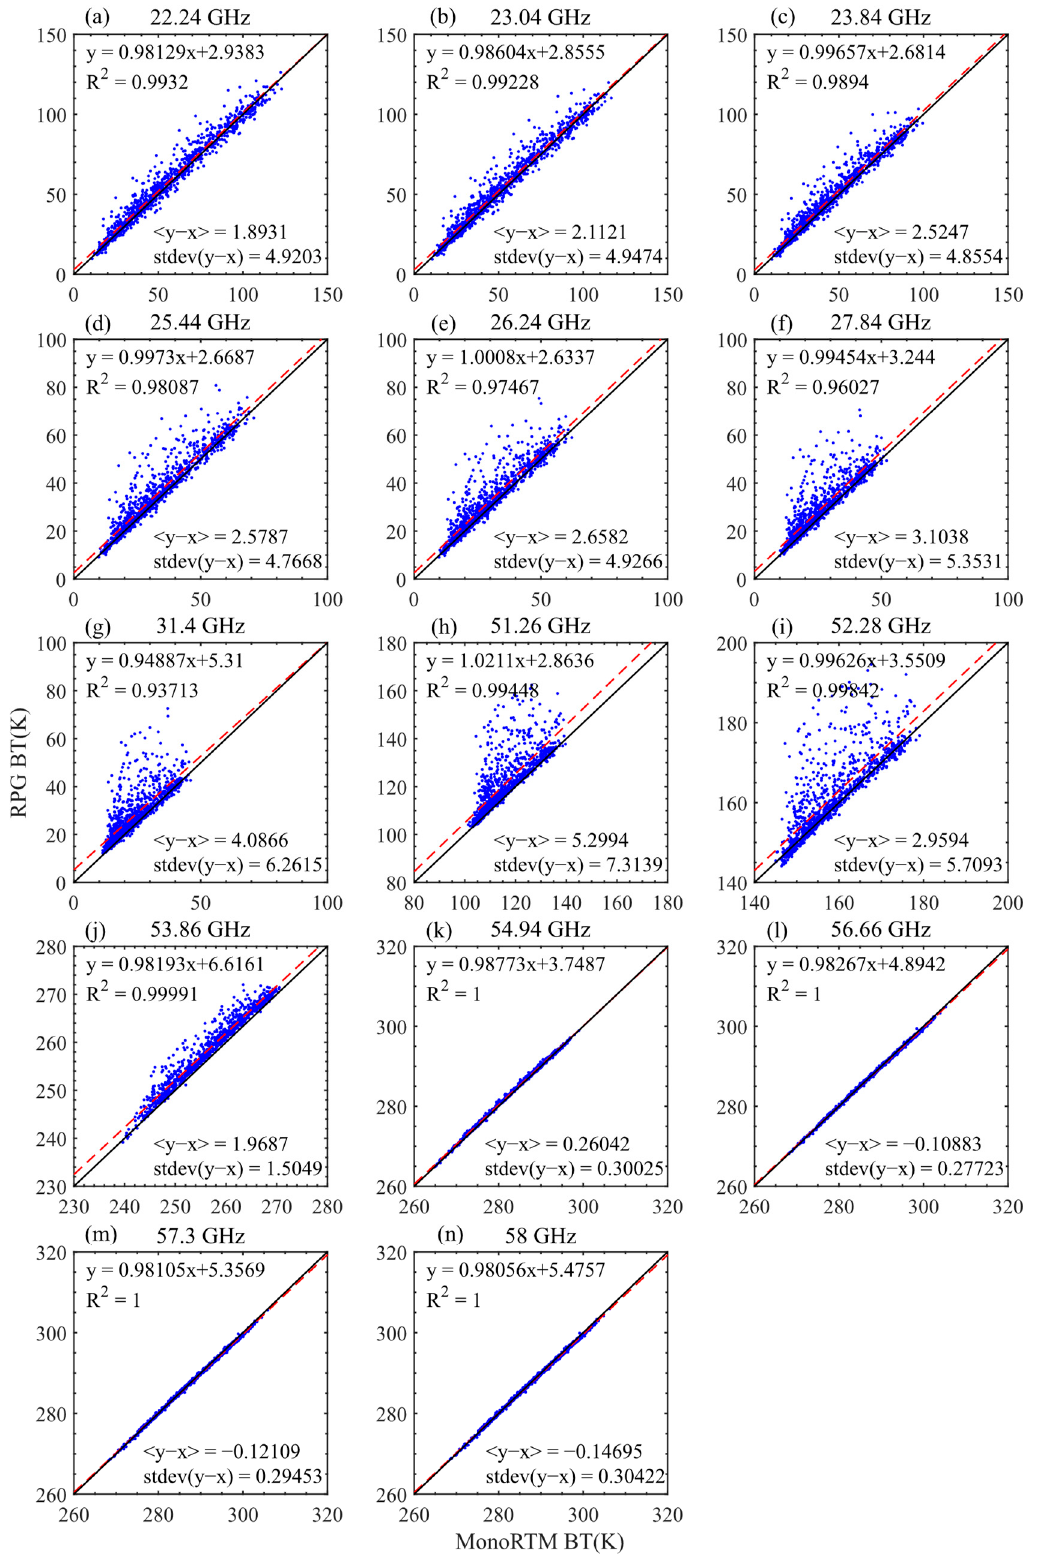
Figure 5. Scatter diagrams of observed BTs and simulated BTs in the no-precipitating cloudy weather (the red dashed lines are fitting straight lines). ( a ) 22.24 GHz, ( b ) 23.04 GHz, ( c ) 23.84 GHz, ( d ) 25.44 GHz, ( e ) 26.24 GHz, ( f ) 27.84 GHz, ( g ) 31.40 GHz, ( h ) 51.26 GHz, ( i ) 52.28 GHz, ( j ) 53.86 GHz, ( k ) 54.94 GHz, ( l ) 56.66 GHz, ( m ) 57.30 GHz, and ( n ) 58.00